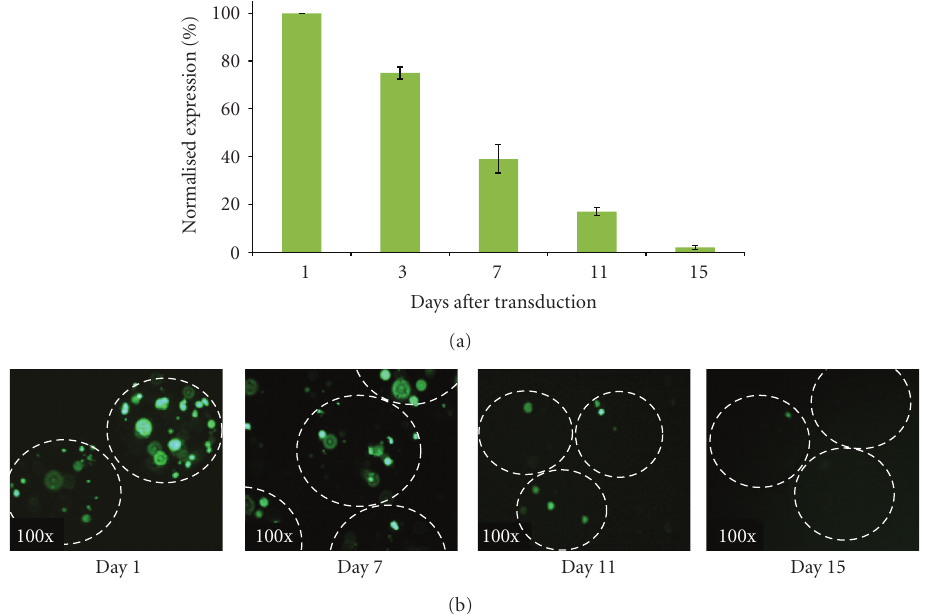
Figure 8: Time-course profile of transgene expression of AP-PEG-A microencapsulated H9c2 cells transduced with Bac-MGFP under optimal transduction condition. The average fluorescein-expressed values (excitation 485 nm, emission 535 nm) were normalized to that of cells with 24hpt having 6h of viral incubation in presence of PBS (taken as 100%) and are represented as normalized mean expression in percentage value (a). The data represent the mean of three di ff erent fields, and error bars represent standard error of the mean. Representative photographs of corresponding transduced microencapsulated cells were taken using fluorescence microscope under 100x magnification at di ff erent days after encapsulation (b). The white-dotted circles show the peripheral surface of the